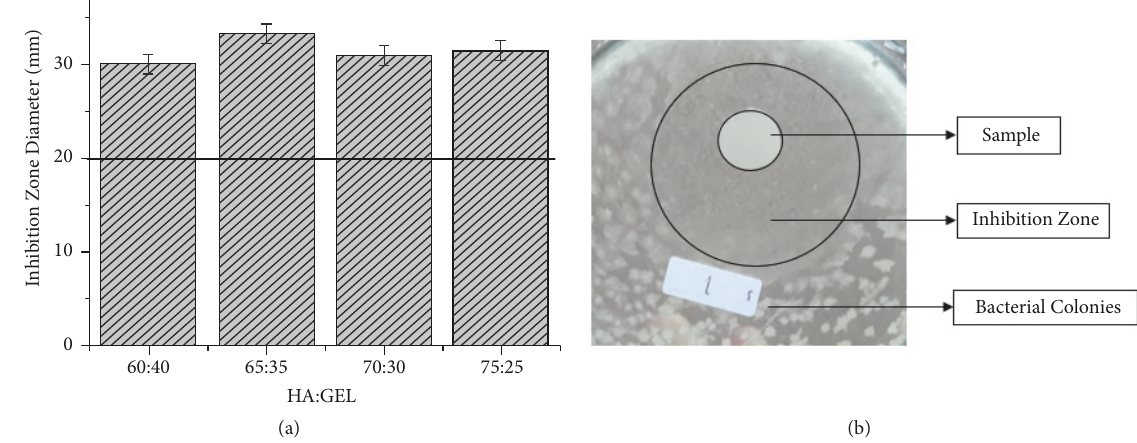
Figure 8: (a) The inhibition zone diameter of IBS in severalHA:GEL ratios. (b) The inhibition zone around the sample that had